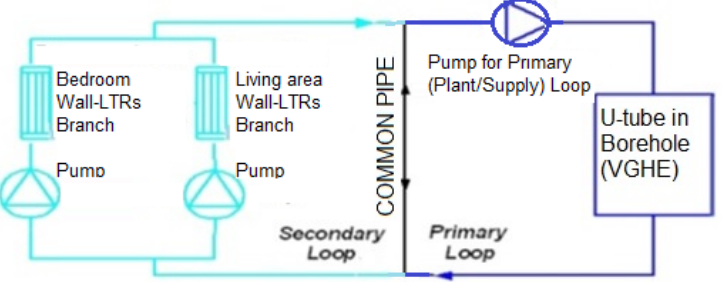
Figure 4. Common pipe for VGHE (supply) loop and low-temperature radiators (LTR) branch (demand) loops.